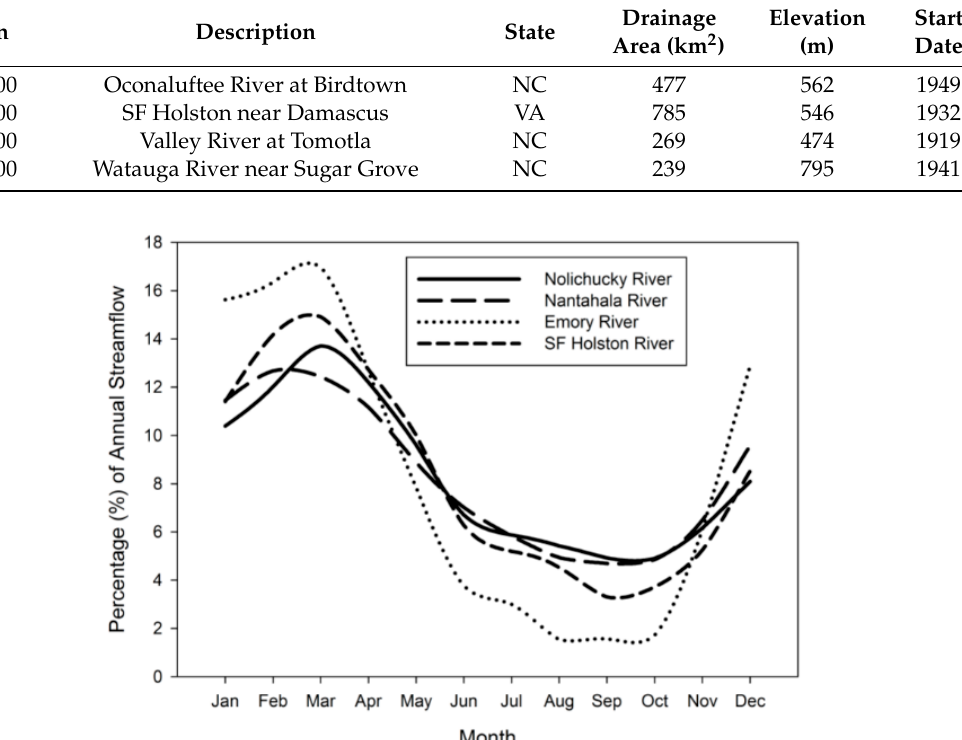
Figure 2. Monthly streamflow for four stations (Nolichucky, Nantahala, Emory, and SF Holston).